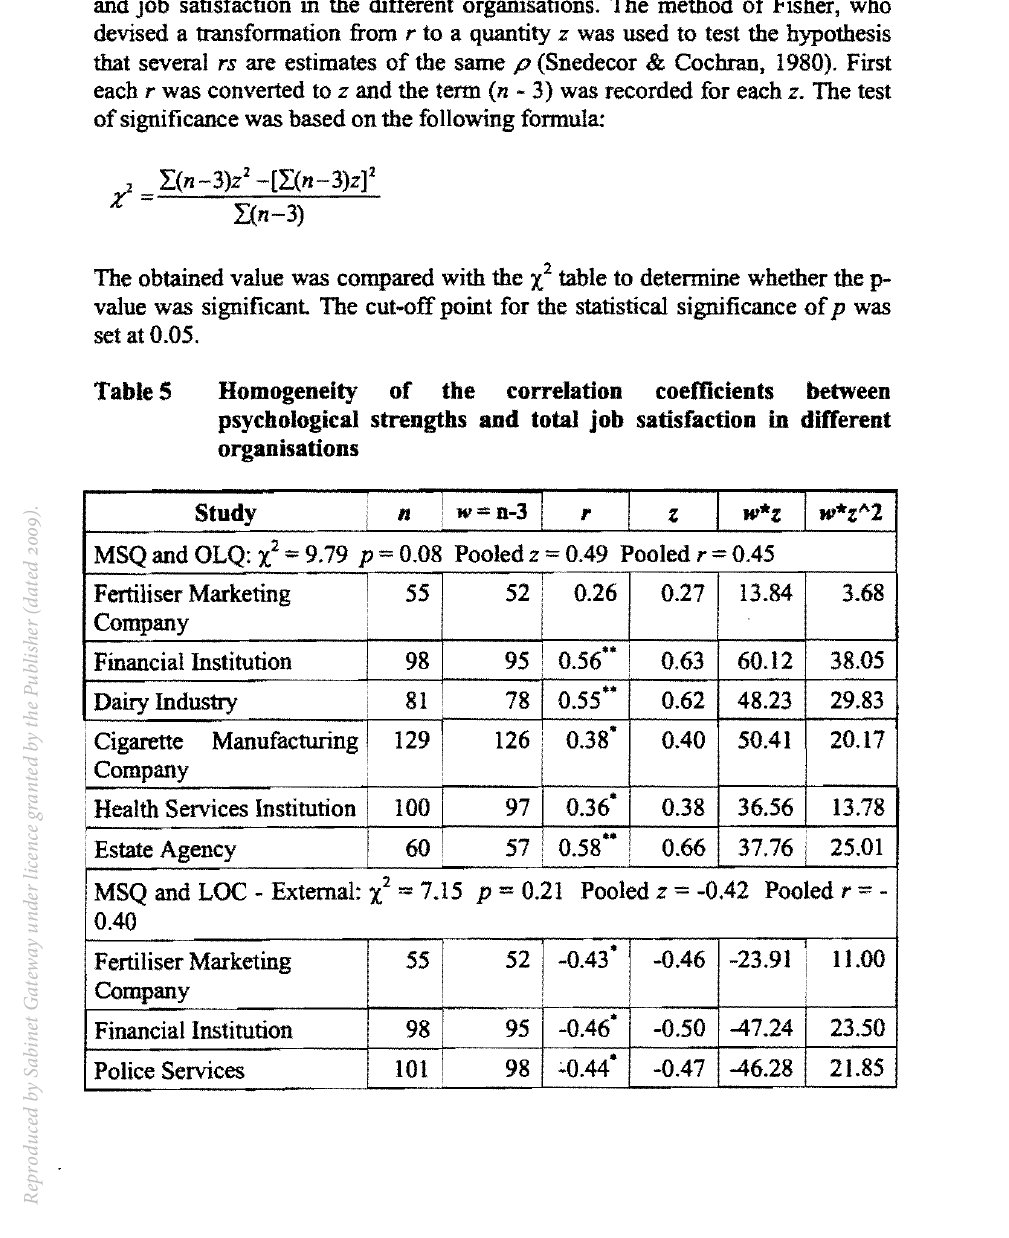
Table 5 Homogeneity of the correlation coefficients between psychological strengths and total job satisfaction in different